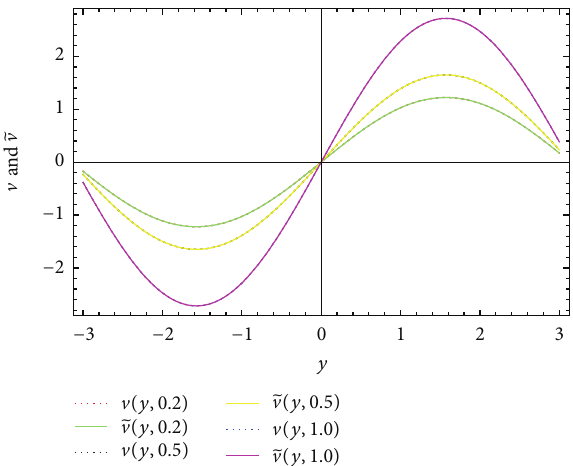
Figure 17: The approximate ̃ V and the exact V solutions for different values of 𝑡 = 0.2 , 0.5, and 1.0 of problem (55), where 𝑁 = 10 and 𝛼 = 𝛽 = 1/2 in the interval [0,1] .